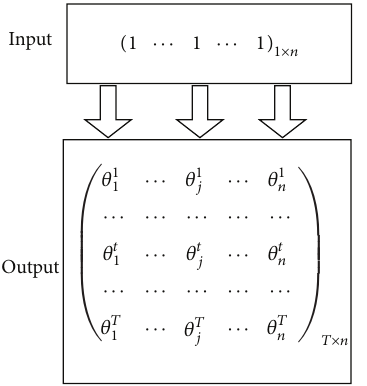
Figure 5: The constructed DEA for measuring dynamic efficiency of DN-DEA.